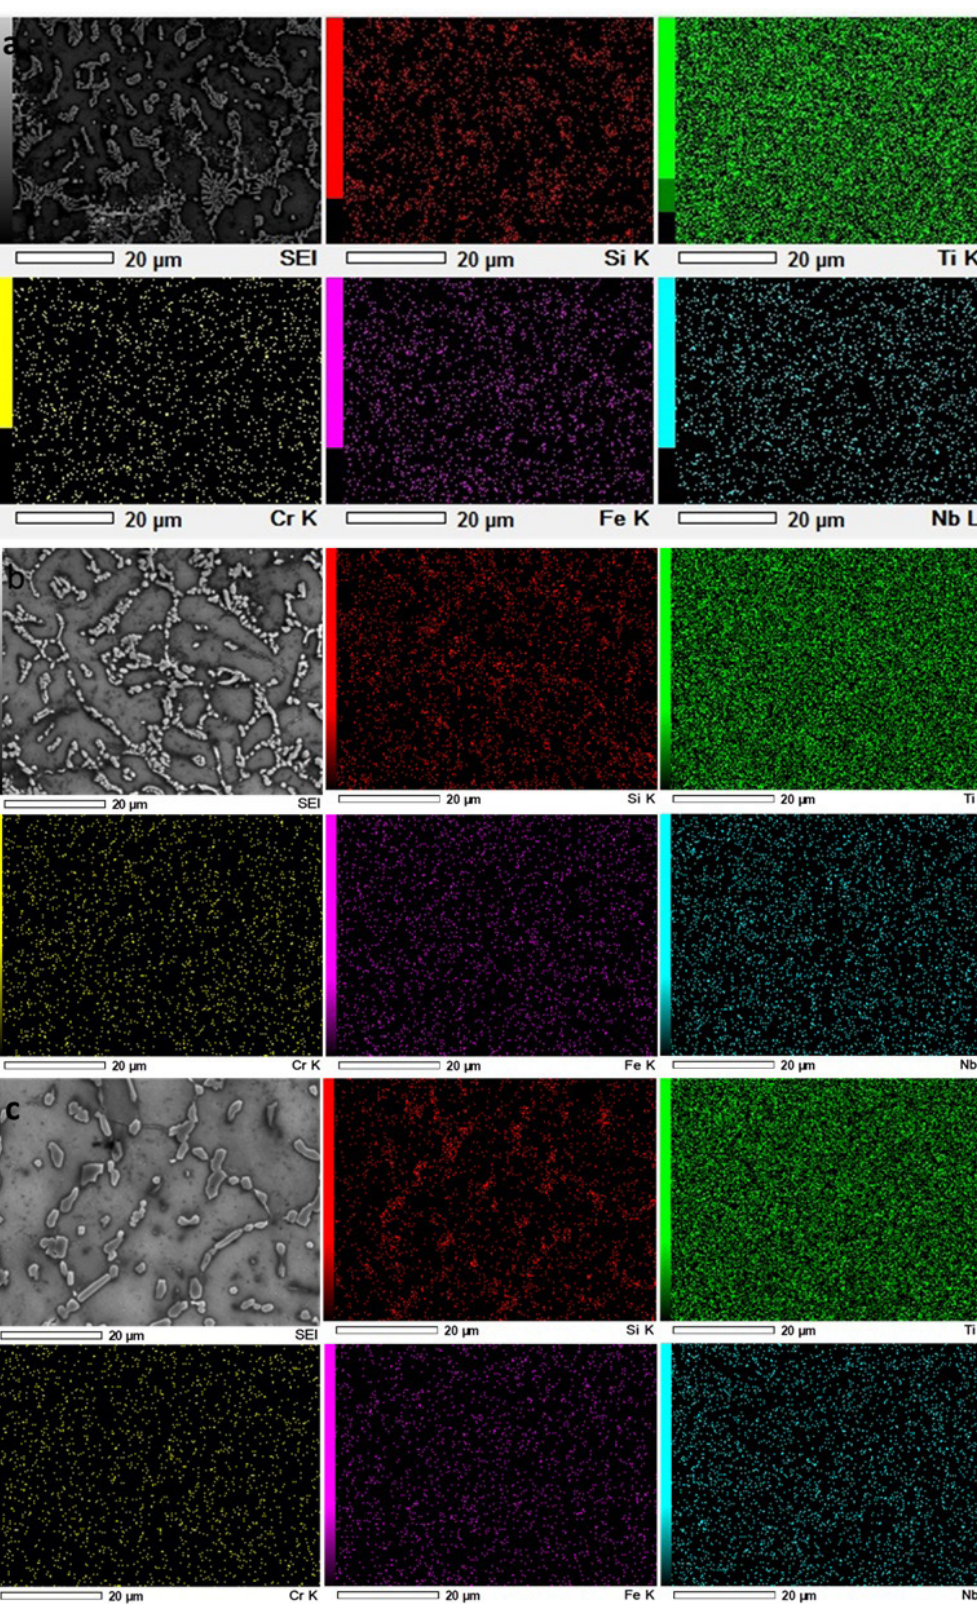
Figure 4. Elemental